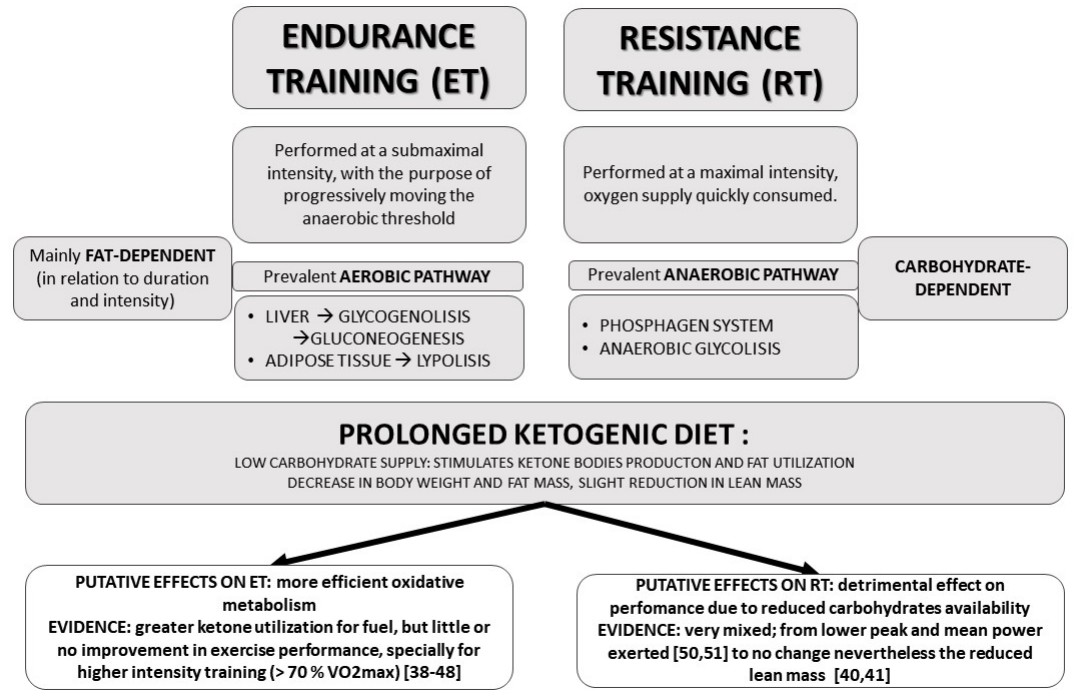
Figure 1. Effects of Ketogenic Diet on the availability of metabolic substrates in relation to the type of exercise.